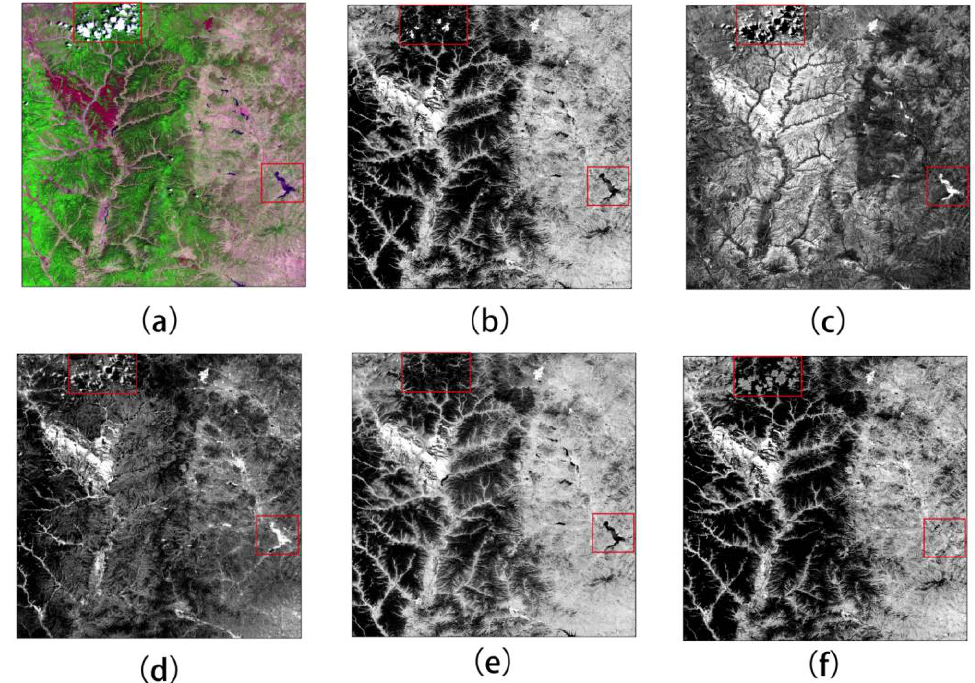
Figure 5. Display of Sentinel-2 image at Qinyuan county and associated image features derived from different spectral indices. ( a ) False color image composited with 12-8A-4 bands; ( b ) NBR+; ( c ) BAI; ( d ) MIRBI; ( e ) ABAI; ( f ) MNBR. (Note that image contrasts among the burned lands, water and clouds were highlighted with red box)